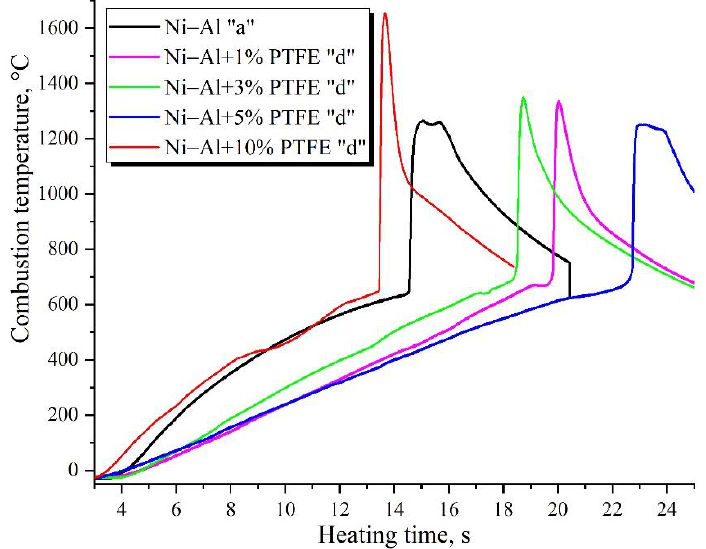
Figure 12. Thermograms of ignition of Ni–Al and Ni–Al–PTFE powder mixtures. Table 3. Temperature of ignition of Ni – Al specimens after HT.